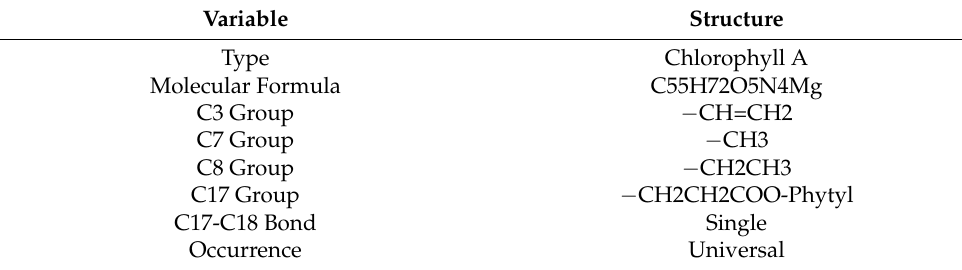
Variable Structure